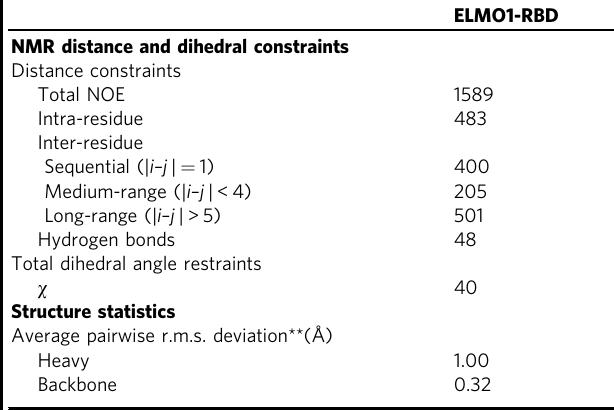
Table 2 Crystallographic statistics of the ELMO1-RBD and RhoG complex.